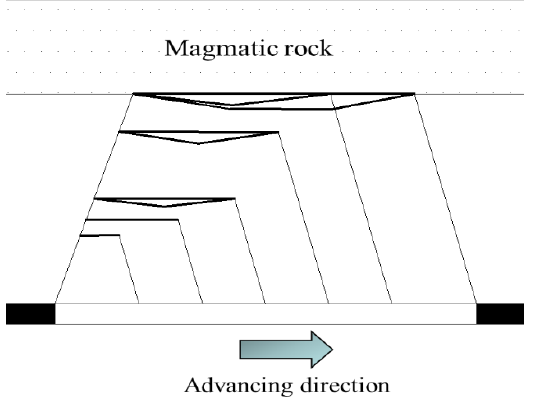
Figure 4. Evolution process of the bed separation under the hard and thick key strata.